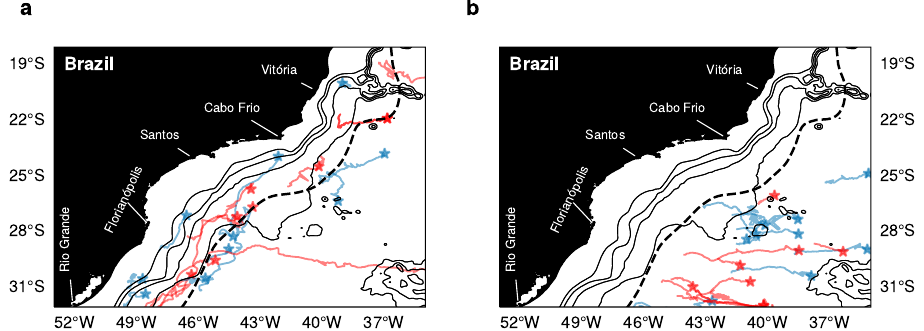
Figure 7. Randomly selected example trajectories of unique long-lived compact eddies in the South Brazil Bight, with blue lines representing cyclones and red lines anticyclones. ( a ) Local Brazil Current eddies and remote eddies that at some time were observed in the Brazil Current region, west of the of black dashed line. Stars represent the location of first detection of the eddy (cf., Figure 6) ( b ) Remote eddies that were never observed west of the black dashed line. The origin of one anti-cyclone in ( a ) is not shown because this eddy was generated west of 35 ◦ W, outside the regional box. Solid black lines depict the 200, 1000, 2000 and 3000-m